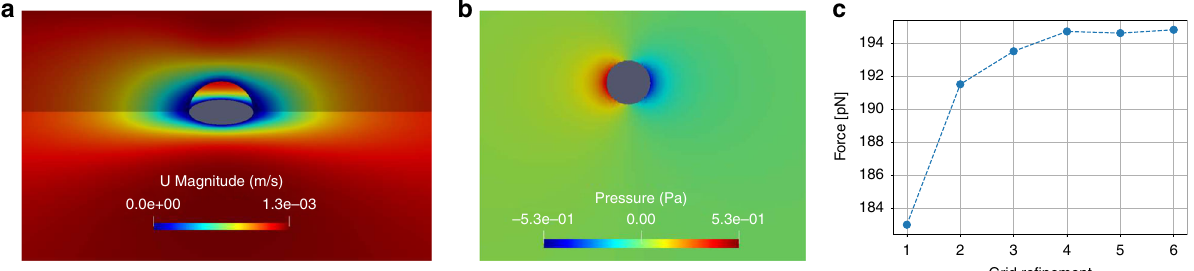
Fig. 5 Simulation of the drag force exerted on a rigid particle moving in a microchannel. Here simulations are performed for particles of diameter 12 μ m moving in a channel of height 38 μ m. a Velocity fi eld in two orthogonal planes intersecting the particle. b Pressure fi eld in the central plane parallel to the walls. c Convergence of the force depending on the grid re fi nement level.